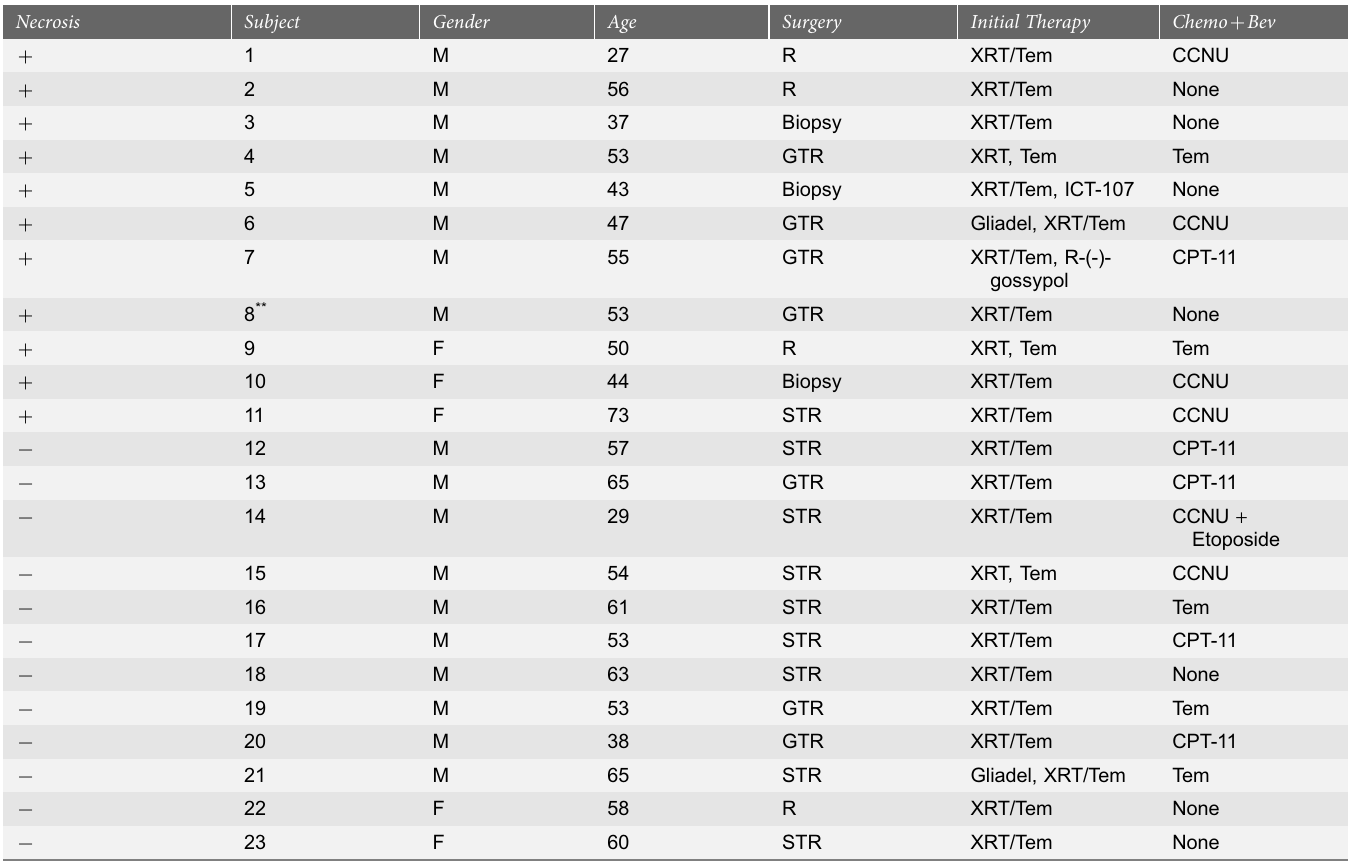
Table 1. Characteristics of patients with GBM at first recurrence.